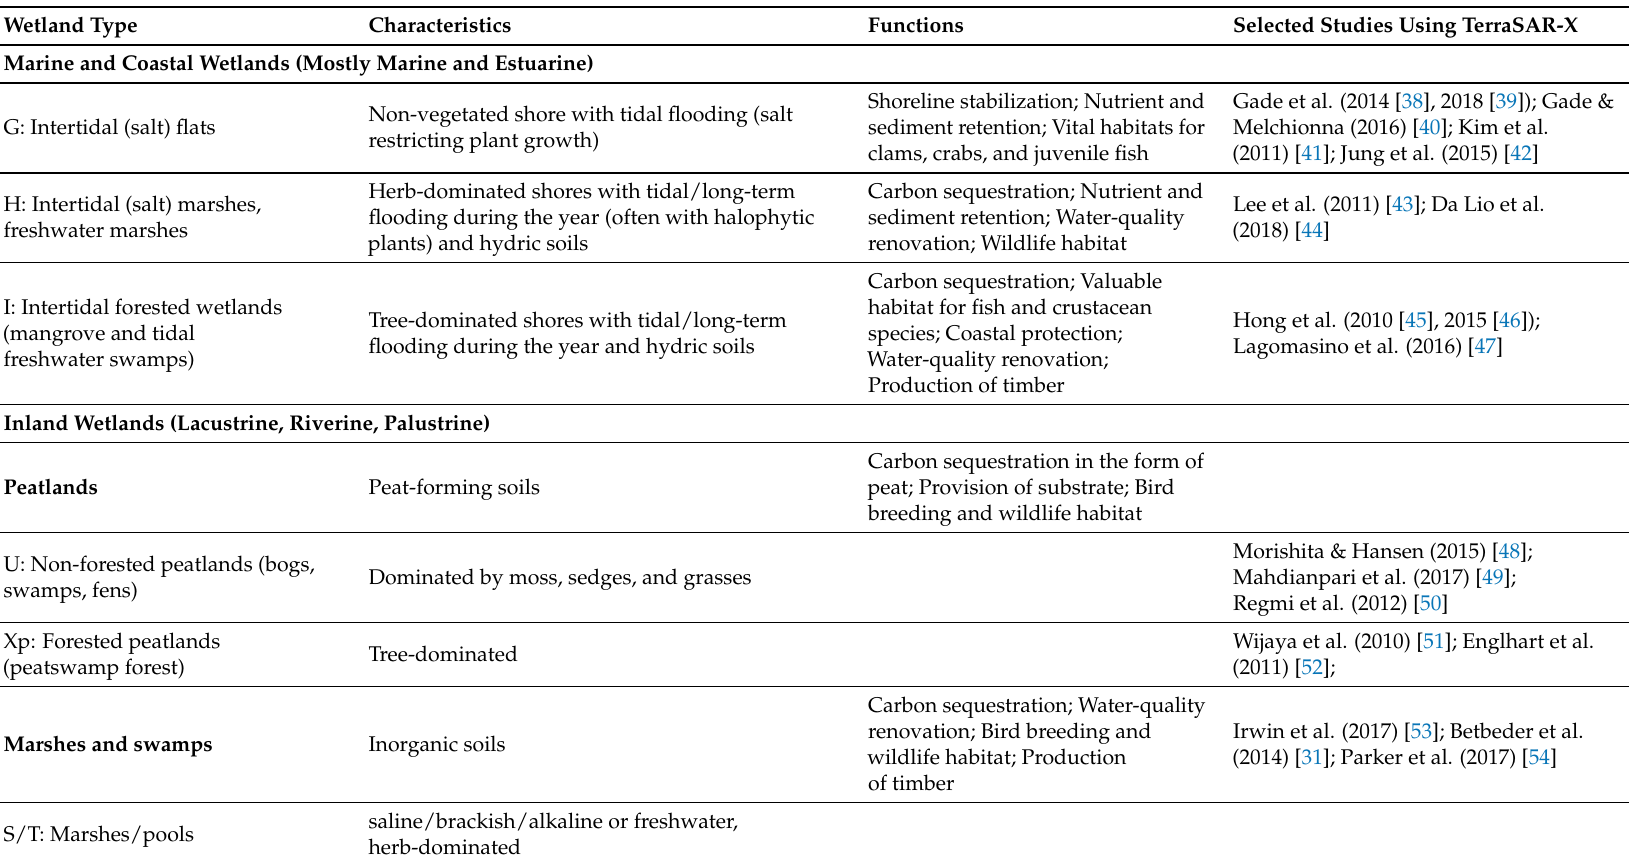
Table 1. Overview of characteristics and functions of major natural wetland types according to the Ramsar international wetland classification [36,37] and TerraSAR-X-related studies, respectively (based on: